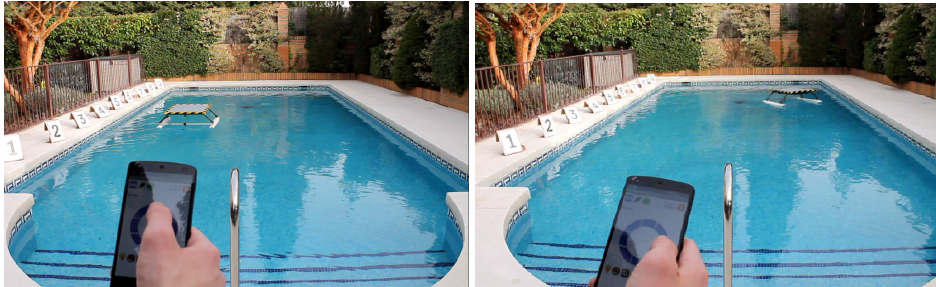
Figure 11. Counter-clockwise U turn via remote control using a modified version of the Ardumotive Bluetooth Controller